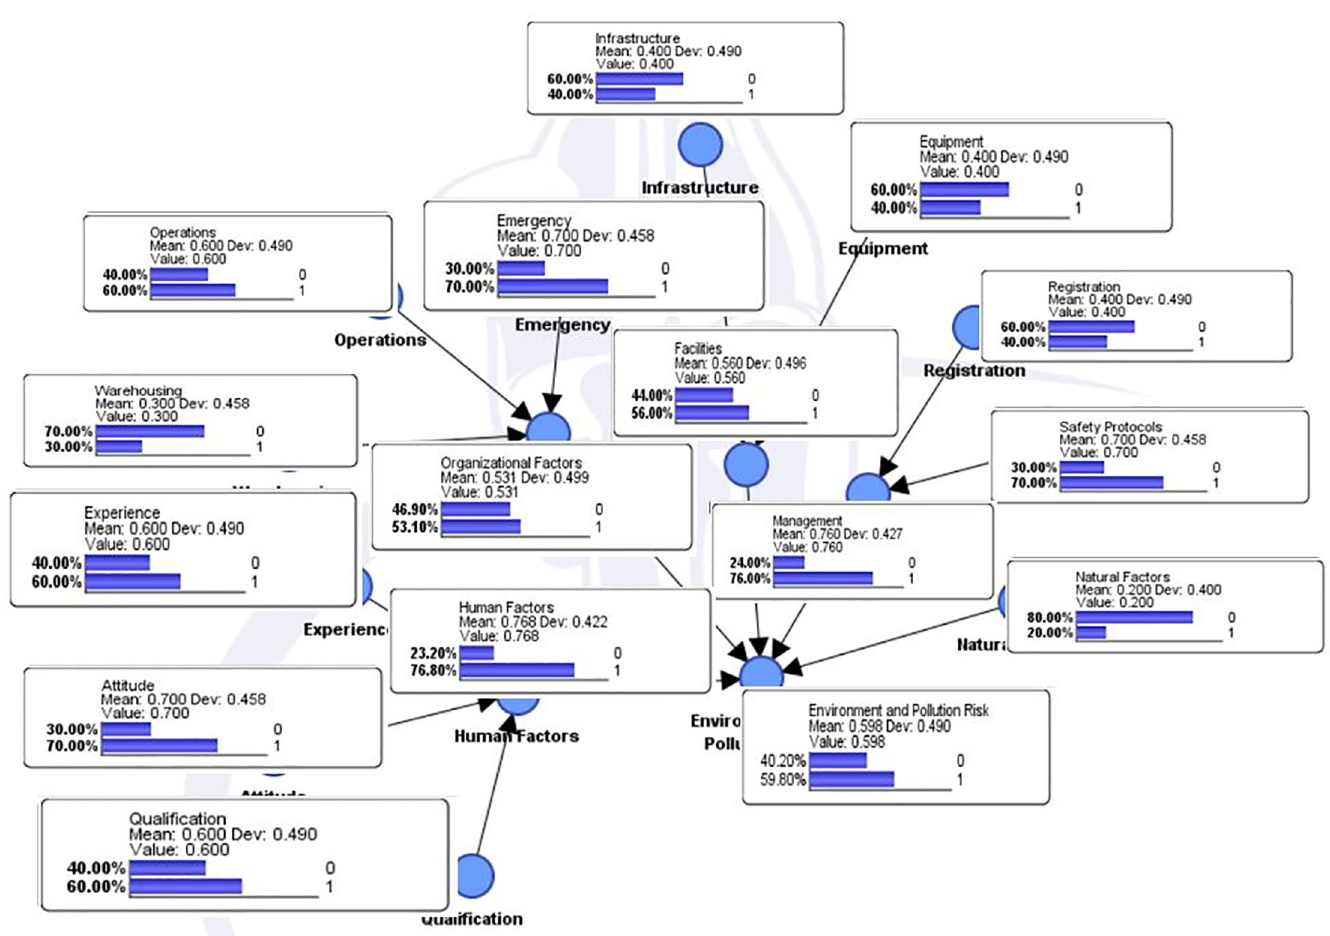
Fig 2. Inference results under normal